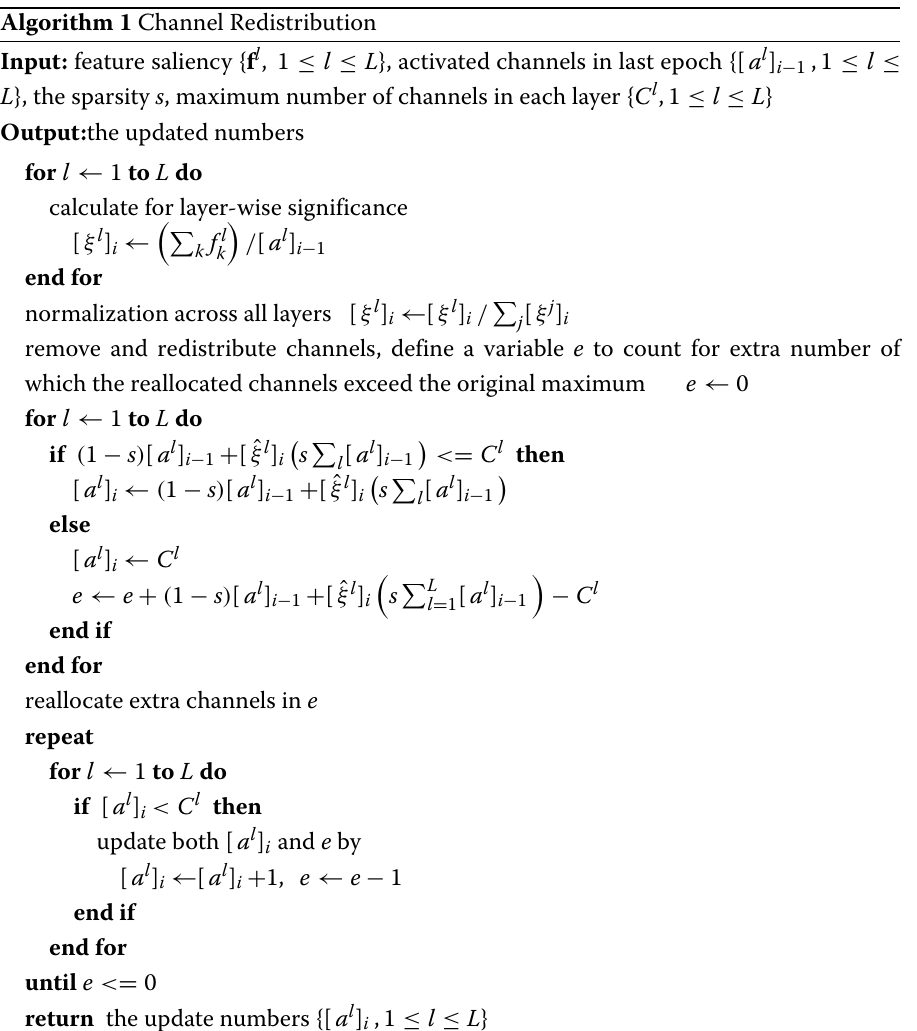
Algorithm 1 Channel